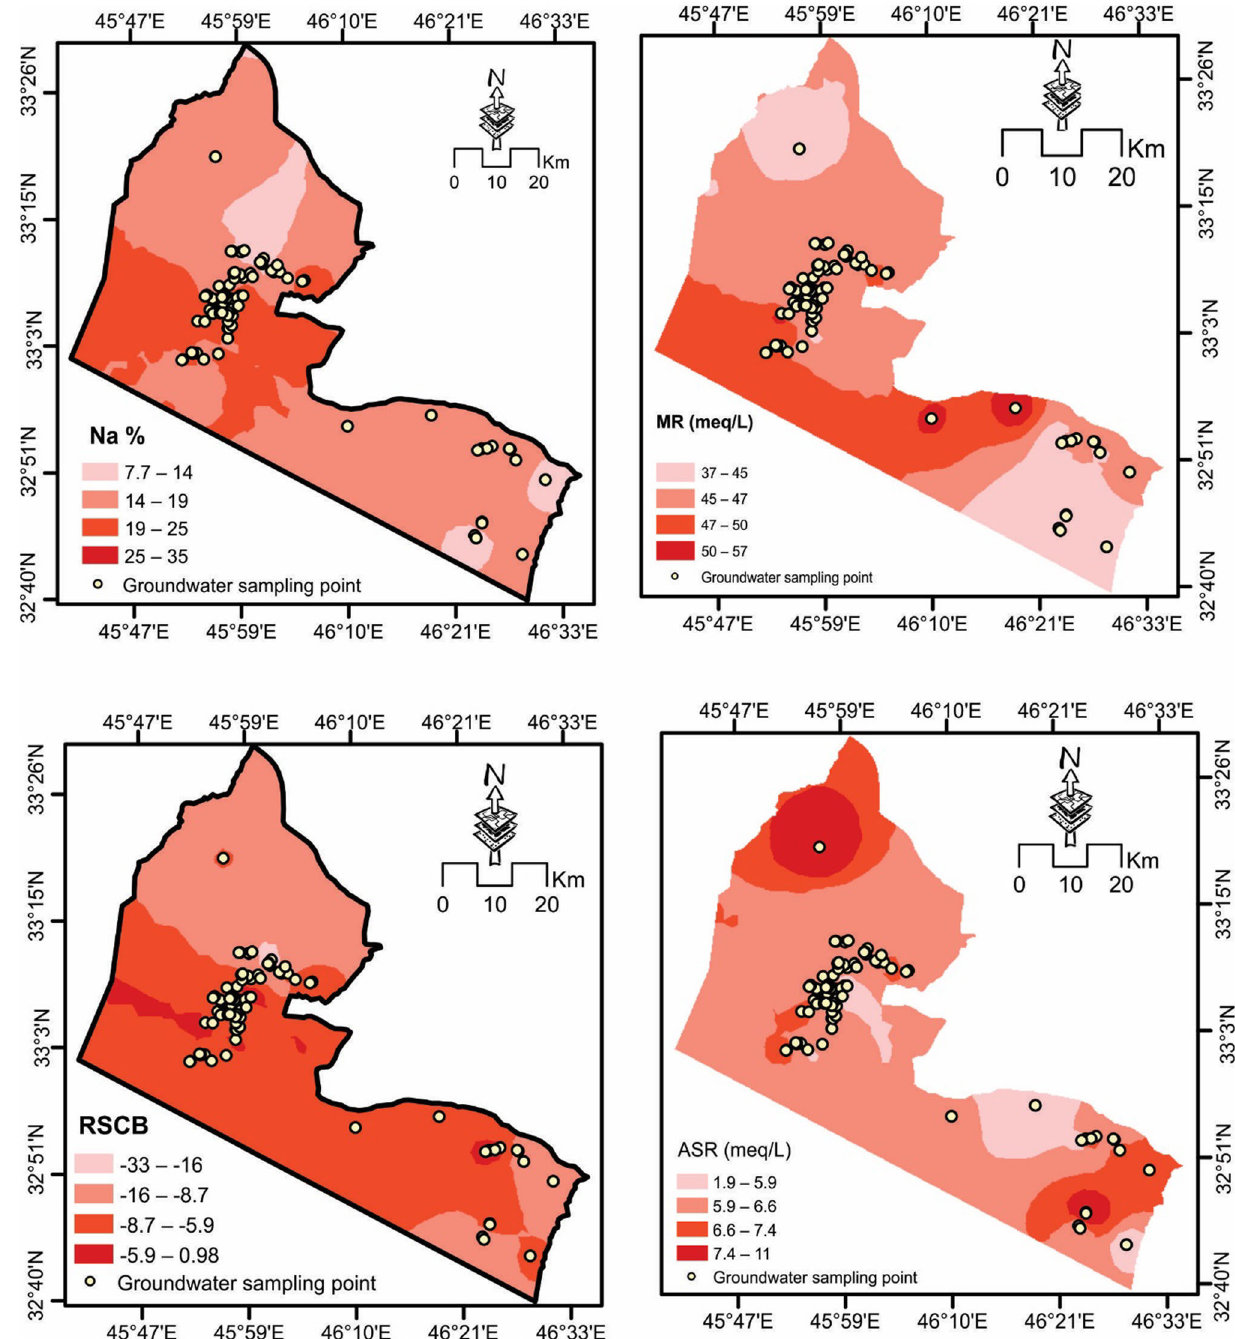
Fig. 15 The water quality zones to irrigation water quality for study